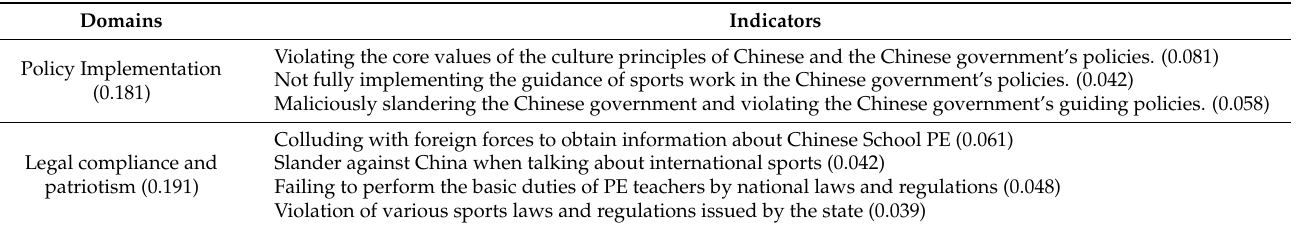
Table 4. The AECPET index